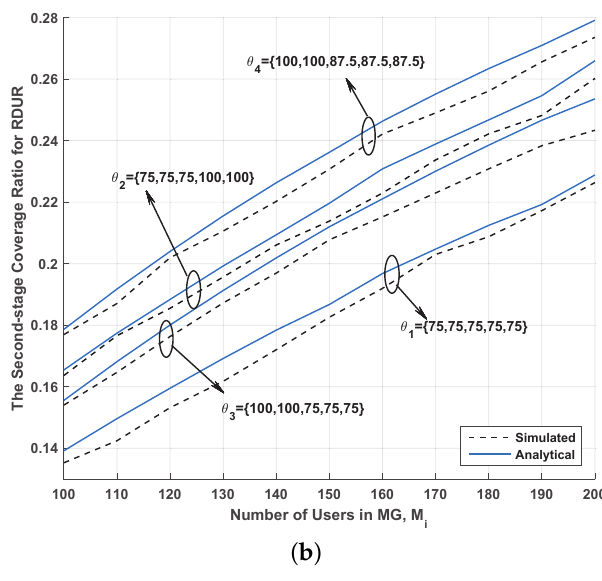
Figure 5. UR selection ratio and coverage ratio for RDUR scheme in different θ . ( a ): UR selection ratio versus the number of users in MG. ( b ): The second-stage coverage ratio versus the number of users in